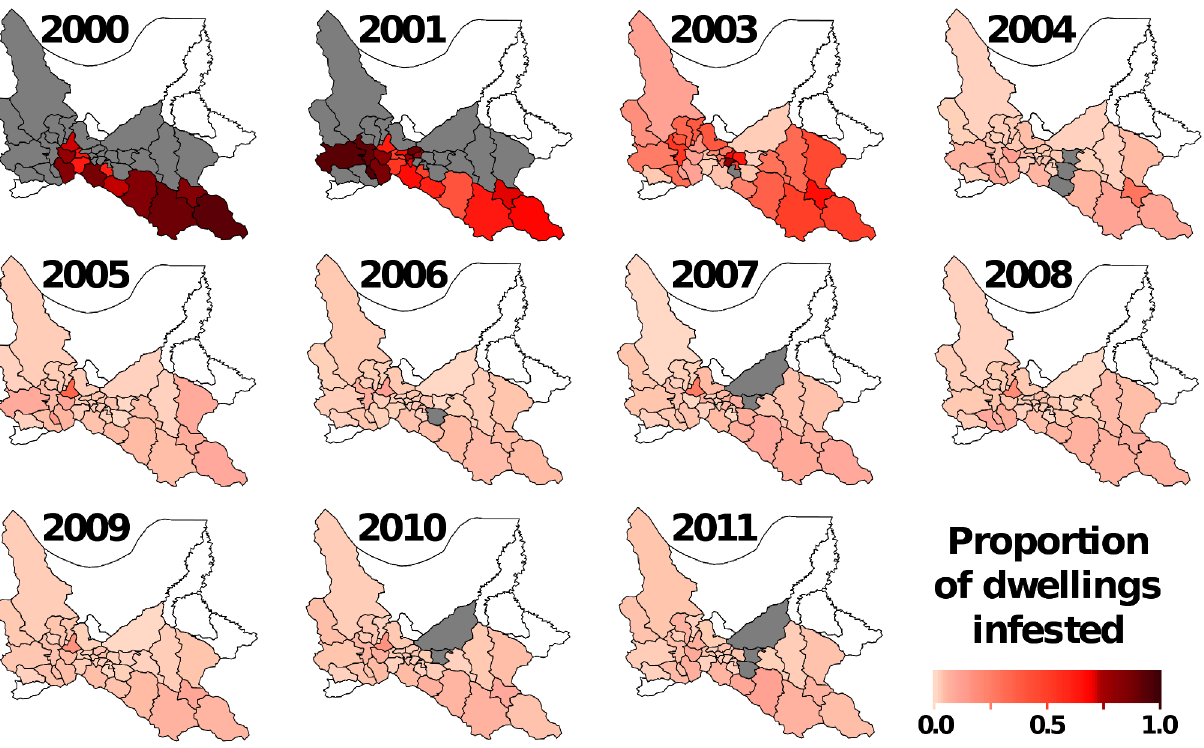
Figure 2. Dwelling infestation by triatomine bugs in at-risk municipalities, Cochabamba, Bolivia. Choropleth maps showing observed dwelling infestation values in each municipality and year. Color codes: pale-pink-to-dark red, proportion of infested dwellings (see scale bar); blank, municipalities not considered at risk and not included in the vector control program nor in the analyses; grey, municipalities without year-specific data.